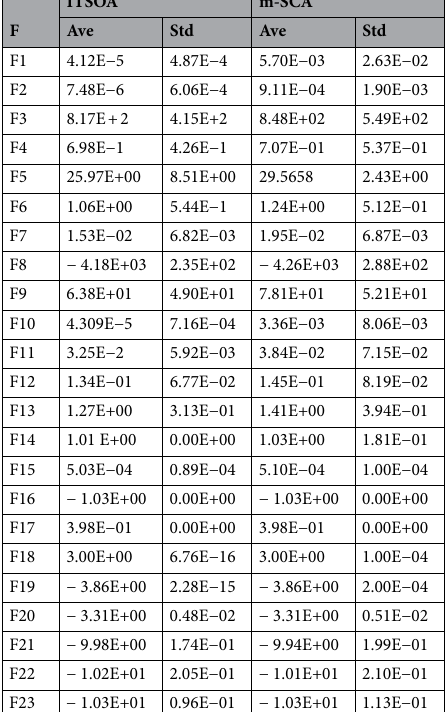
Table 2. The Mean and Std. values of test functions using ITSOA, and m-SCA 42 with D =